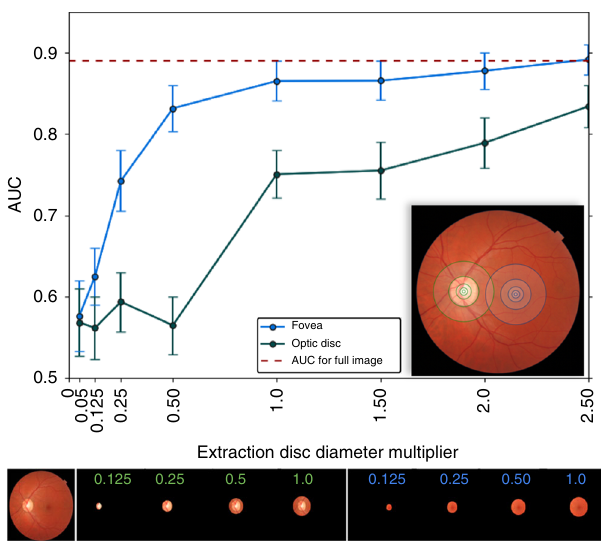
Fig. 5 Model performance on crops around fovea and optic disk. The plot shows model performance in predicting ci-DME on the primary clinical validation set, as measured by AUC when cropped circular images are used to train and validate the model. The blue line indicates the performance when cropped circular images of different sizes (radius of multiples of disc diameter from 0.05 to 2.5) centered at the fovea are used; the green line indicates the corresponding performance when the crops are centered at the optic disc. (Inset) Image depicting some of the regions of different radii (0.05, 0.125, 0.25, 0.5, and 1 disc diameter) around the fovea and optic disc. Bottom panel: Fundus image, followed by a sample of the crops extracted by centering at the optic disc (green) and fovea (blue), with the extraction radius in multiples of disc diameter indicated in each crop. Error bars are 95% con fi dence interval using n = 2000 samples with